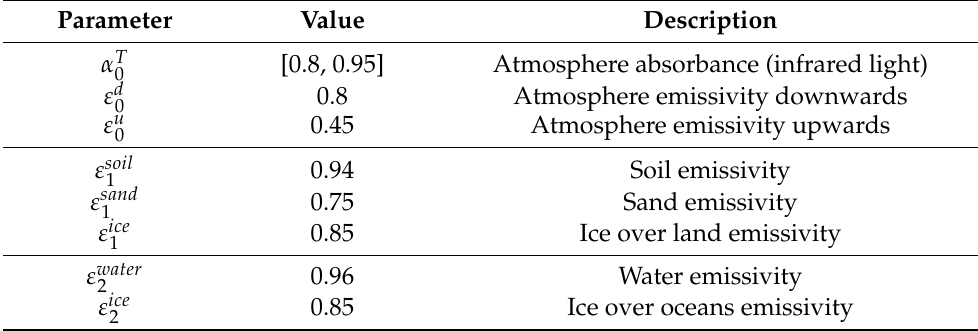
Table 4. Atmospheric absorbance α T bodies on Earth.